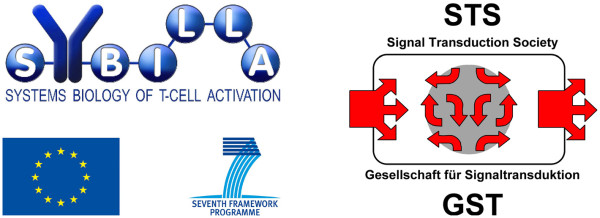
The conference was mainly supported and organized by the EU FP7 consortium SYBILLA (Systemsbiology of T-cell activation) and STS (The Signal Transduction Society).